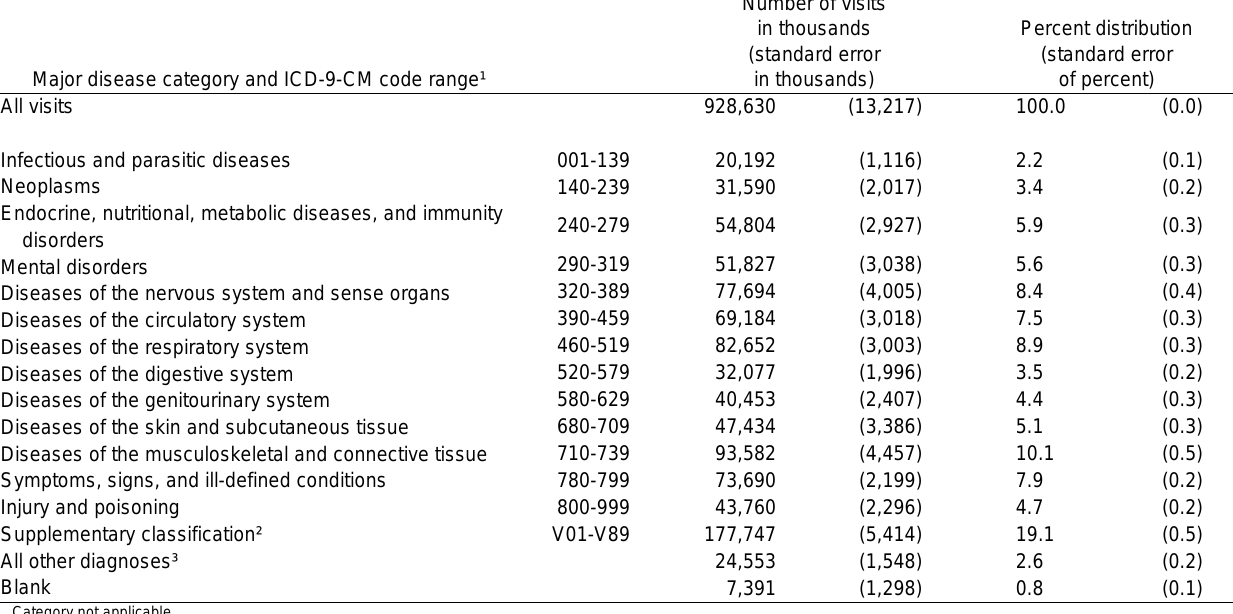
Table 15. Primary diagnosis at office visits, classified by major disease category: United States,